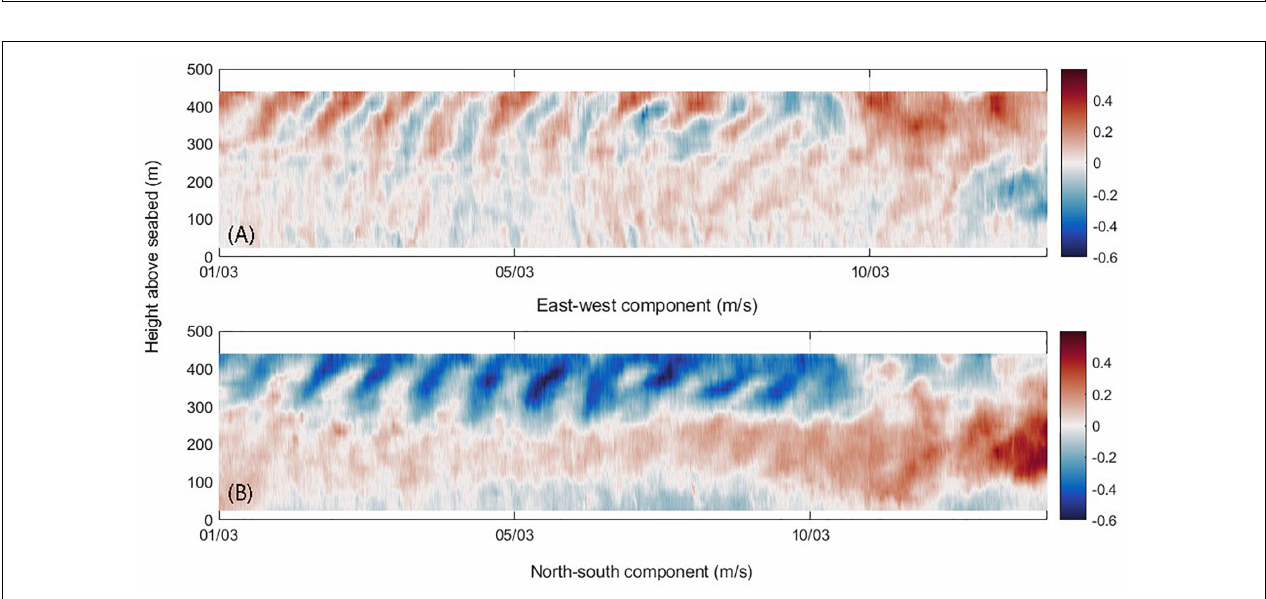
FIGURE 6 | Representative vertical profiles of seawater δ 13 C (top left) and (cid:49) 14 C (top right) compositions from the Perth Canyon compared with data from earlier cruises in the region: GEOSECS (1978, station 436), WOCE (1995, station 435), and US CLIVAR/CO2 (2009, station 189). Satellite map (bottom) show relevant sampling sites from the Falkor (Perth Canyon), GEOSECS, WOCE, and CLIVAR cruises.